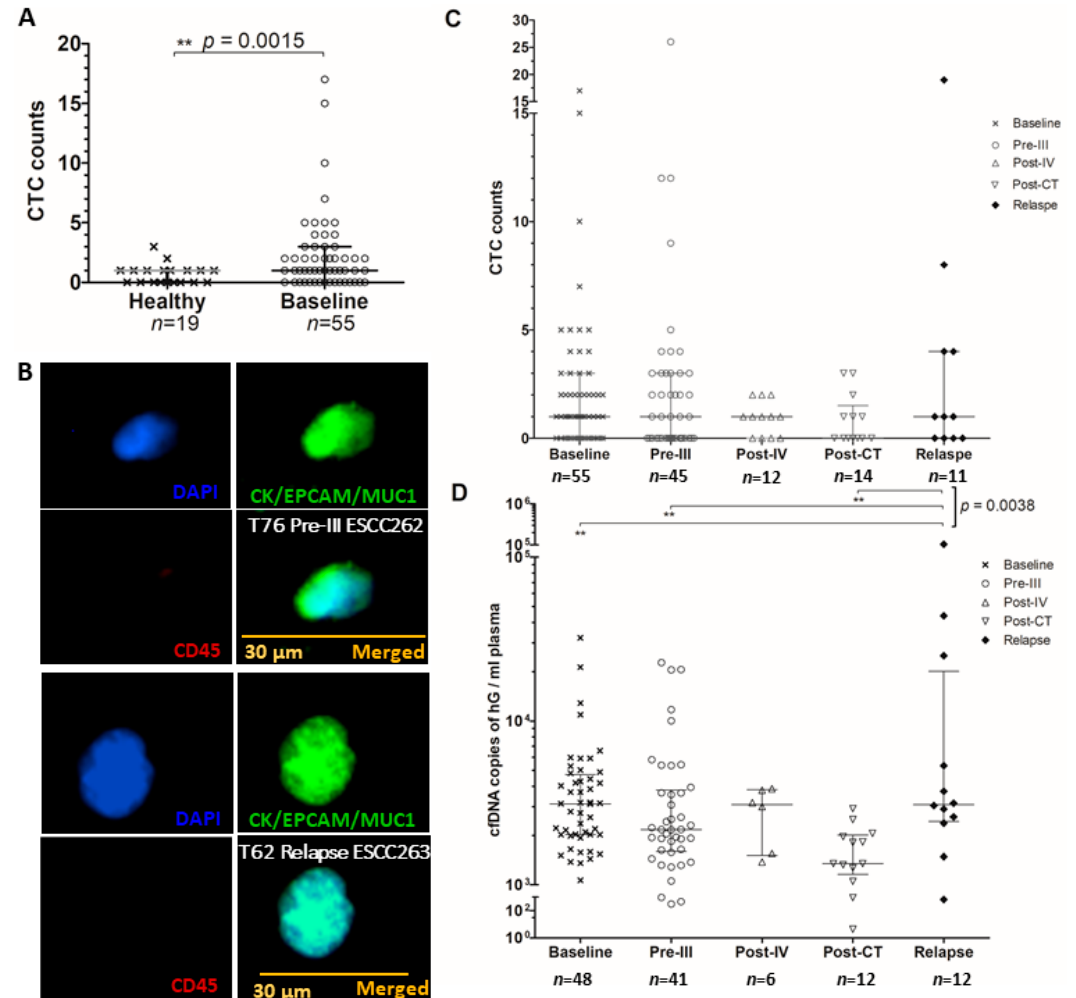
Figure 1. (A) CTC counts of healthy individuals and ESCC patients. (B) Representative CTC images from two ESCC patients. Liquid biopsy longitudinal serial monitoring of ESCC patents by (C) CTC counts and (D) cfDNA level. The median with interquartile range is indicated by error bar. The cfDNA levels were compared by ANOVA. ** p < 0.01. Table 1. Baseline characteristics of CTC bloods for CTC counts and cfDNA levels of ESCC